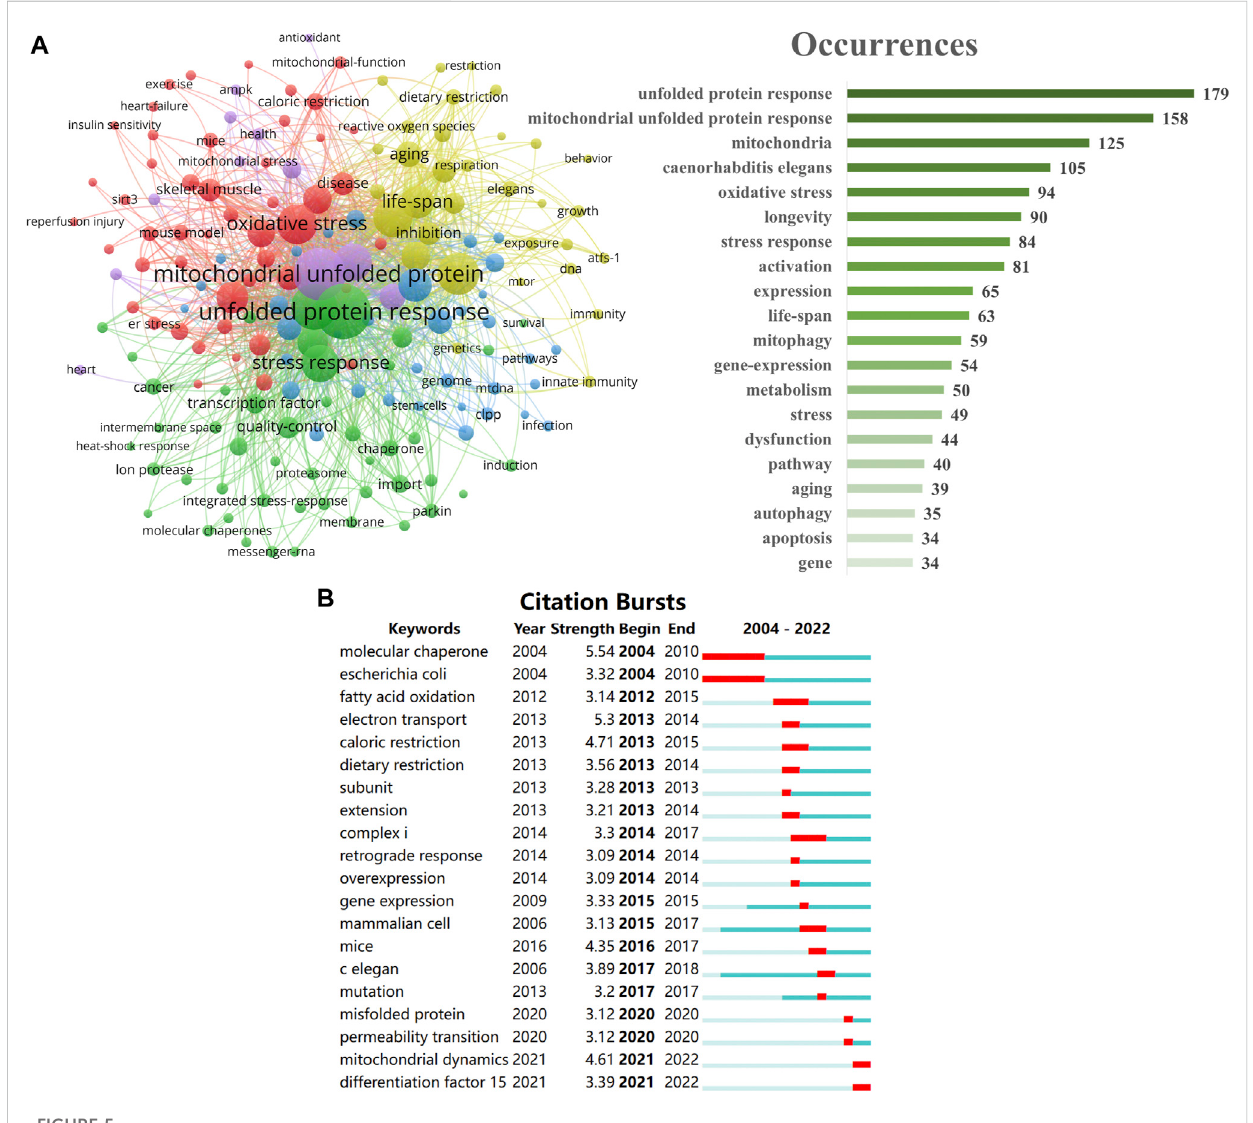
cardiovascular disease, and neurodegenerative diseases. UPR mt plays